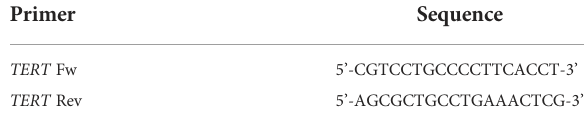
TABLE 2 Primer sequence used for TERT